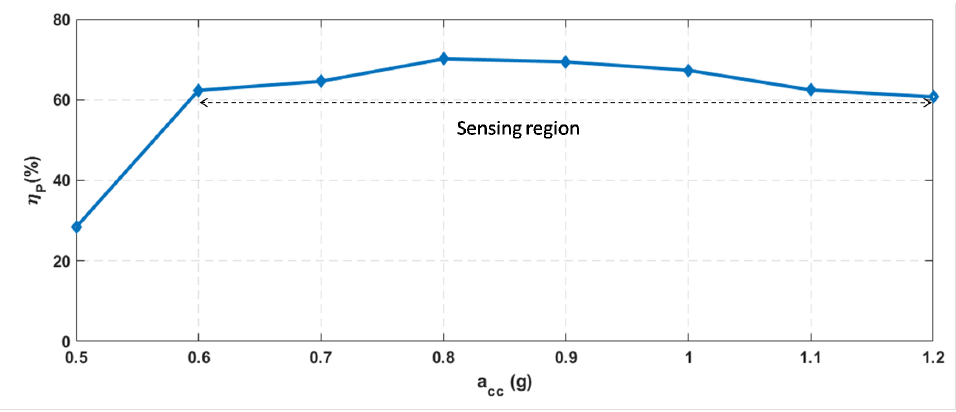
Figure 5. EAWVS power conversion efficiency η p vs. acceleration a cc (experimental